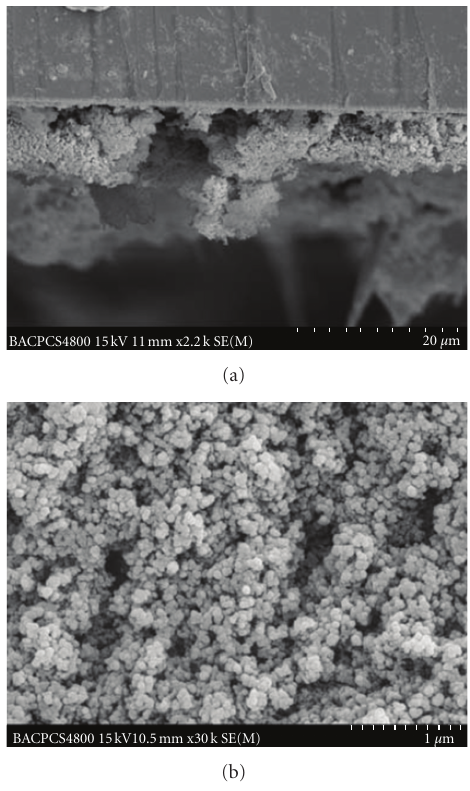
Figure 4: SEM cross-sectional (a) and top-view image (b) of ZnO tetrapods/TiO 2 photoanode fabricated through colloidal spray coating.